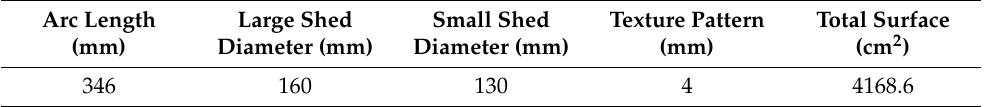
Figure 4. Examples of the effect of pre-conditioning on the HC index. Table 2. Characteristics of the used